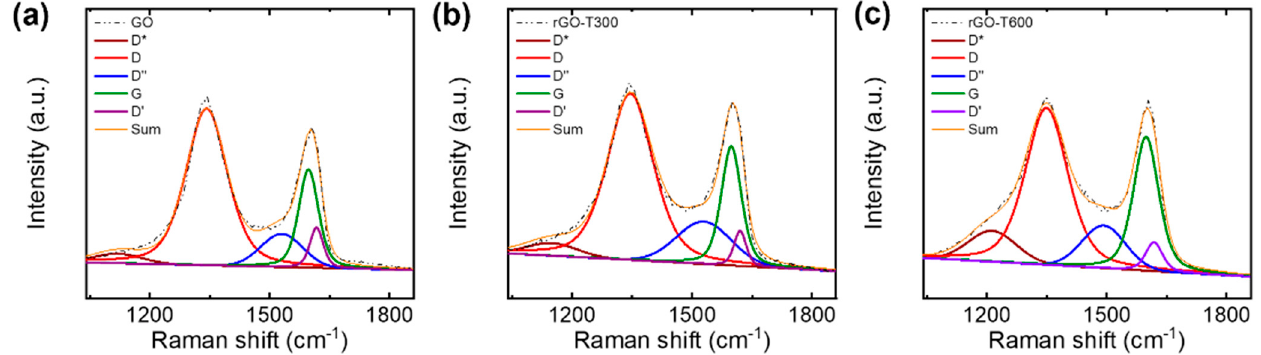
Figure 6. Deconvolution of Raman spectra of ( a ) GO and ( b , c ) rGO flakes.